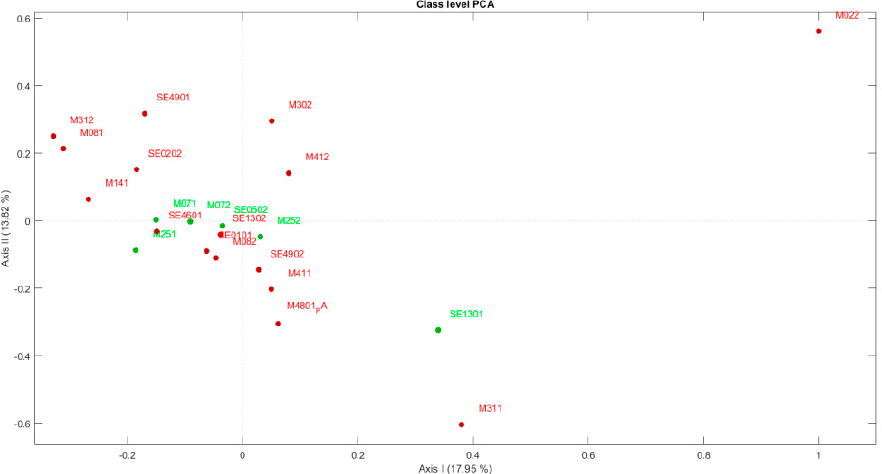
Figure 10. The results of PCA at the class level. Green: OSA − atherosclerosis. Red: OSA + atherosclerosis.